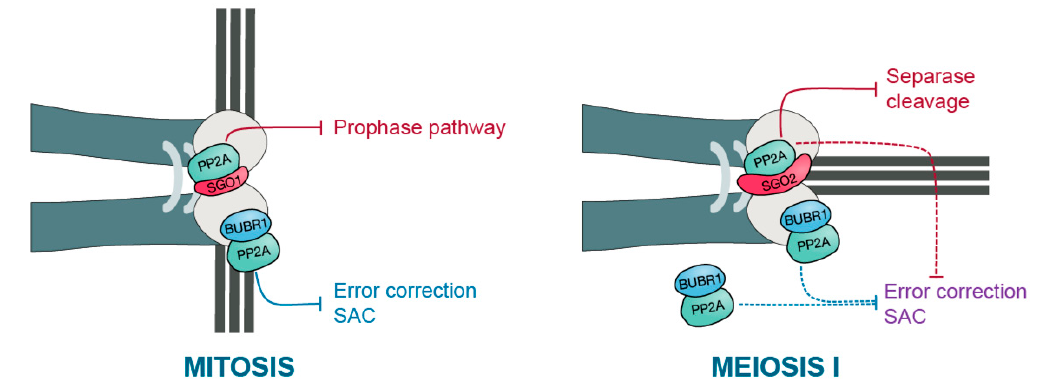
Figure 2. PP2A-B56 kinetochore functions in mitosis and oocyte meiosis I. The scheme depicts the kinetochore region on telocentric murine chromosomes in mitosis (on the left) and meiosis I (on the right). In mitosis, PP2A-B56 is brought to the centromere region by Sgo1 to protect cohesin there from prophase pathway-dependent removal. In parallel, PP2A-B56 is localized to the kinetochore by BubR1 to counteract substrate phosphorylation at the kinetochore, and hence, error correction and SAC activity. In contrast, during meiosis I in oocytes, PP2A-B56 is brought to the centromere region by Sgo2, this time to protect cohesin from Separase-dependent cleavage. Although it also localizes to the kinetochore through BubR1, this BubR1-dependent localization of PP2A-B56 is dispensable for anaphase I onset in oocytes. Either cytoplasmic BubR1-PP2A-B56 or Sgo2-bound PP2A-B56 at the kinetochores may be sufficient to silence error correction and SAC activity in oocytes.